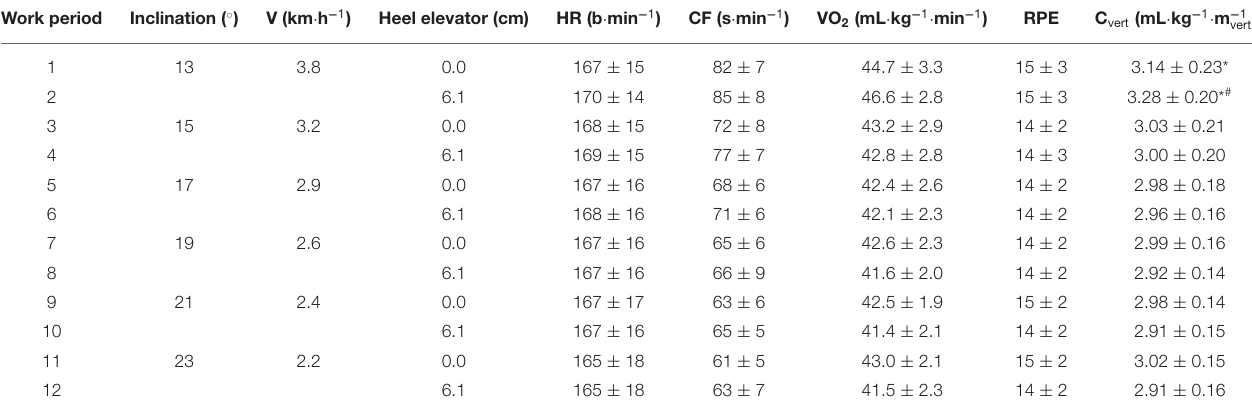
TABLE 2 | Physiological results from sub-maximal workloads ( N =